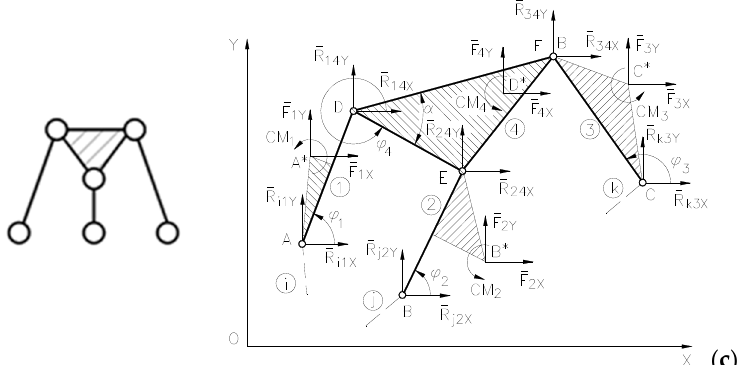
Figure 1. Assur group types—dyad and triad: ( a ) kinematic scheme for the dyad (RRR) [21], ( b ) kinetostatic scheme for the dyad (RRR) [21], and ( c ) kinematic and kinetostatic schemes for the triad (RR-RR-RR) [22] where: R is rotation, F is the force vector (components along axes), and R is the joint reaction force vector (components along axes).